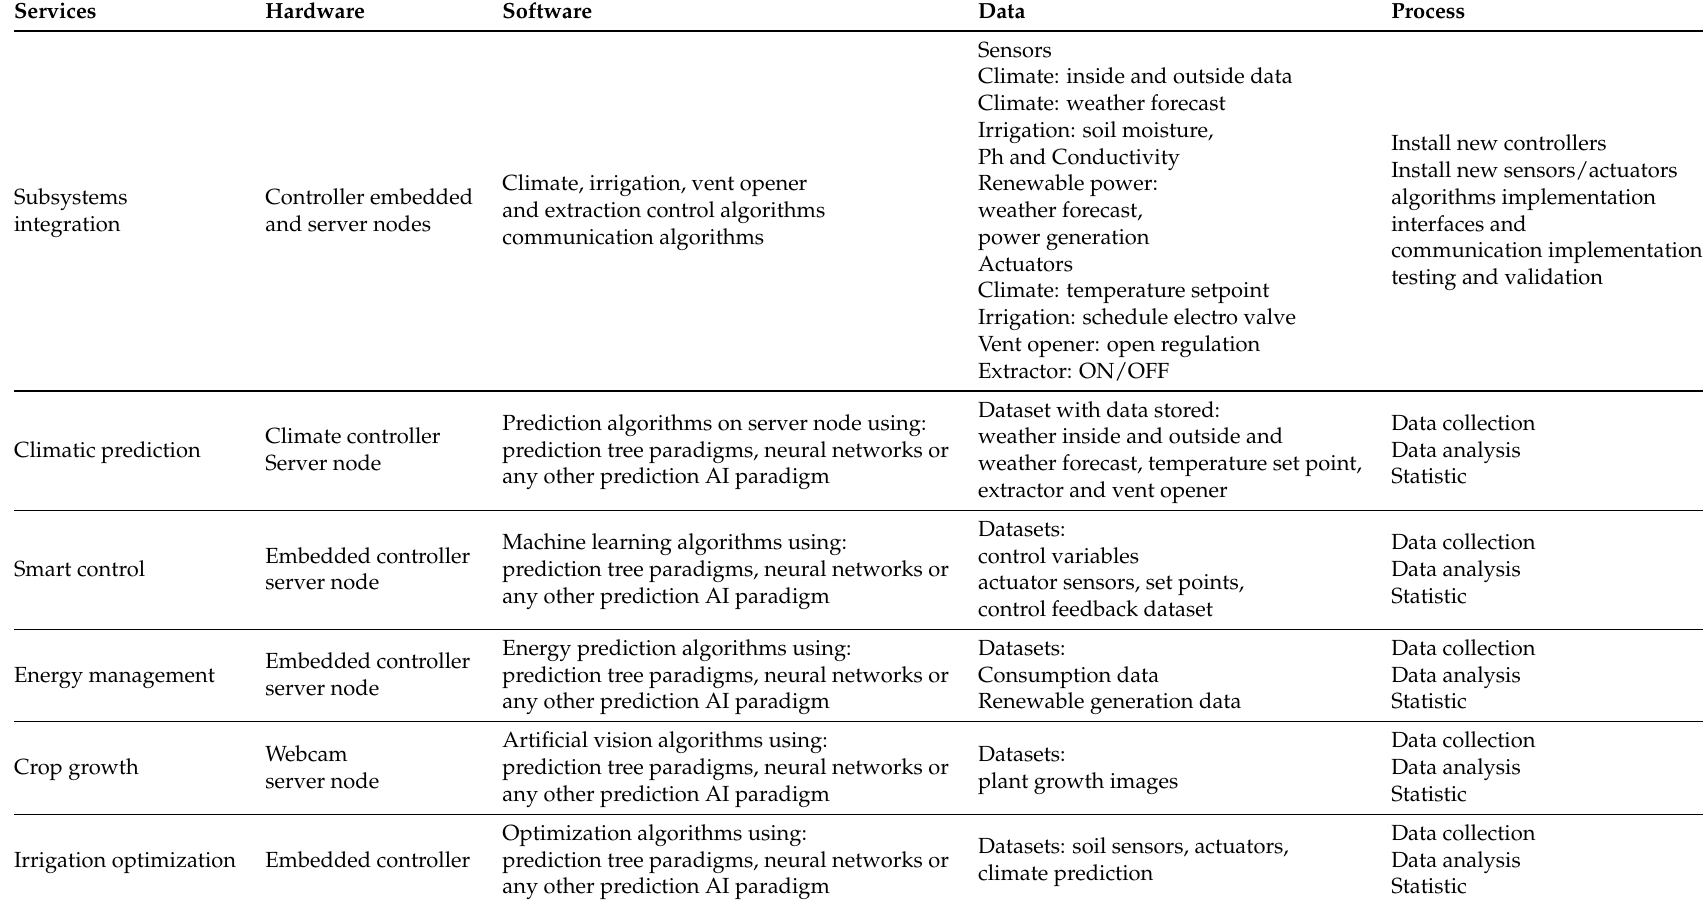
Table 1. Potential services incorporated into current automated